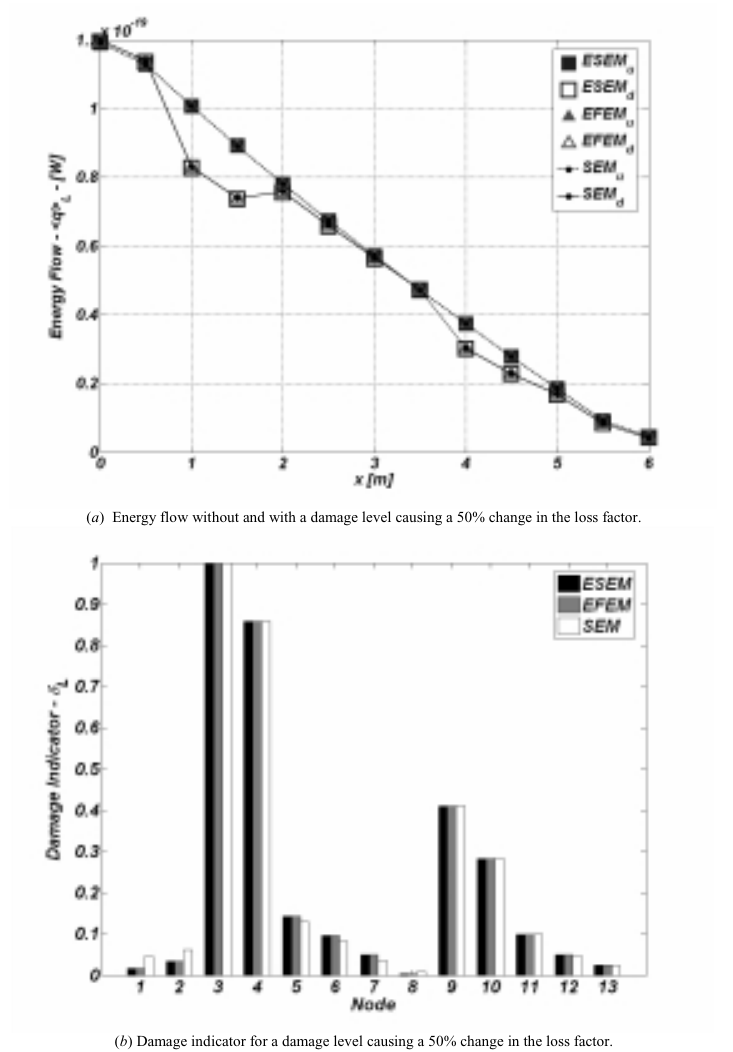
Fig. 3. Longitudinal energy flow and damage indicator by ESEM, SEM and